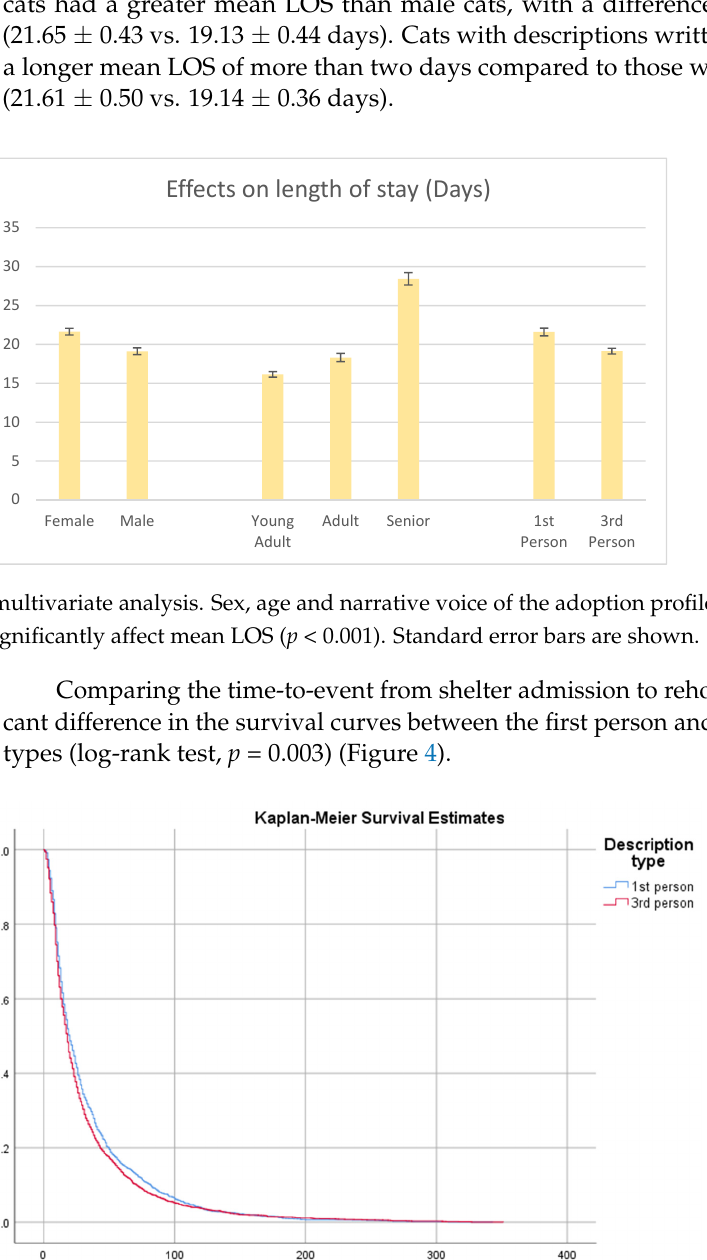
Table 5. Summary of the results from the multivariate analysis, including the analysis of potential interactions. Description = narrative voice (i.e., first person vs. third person).